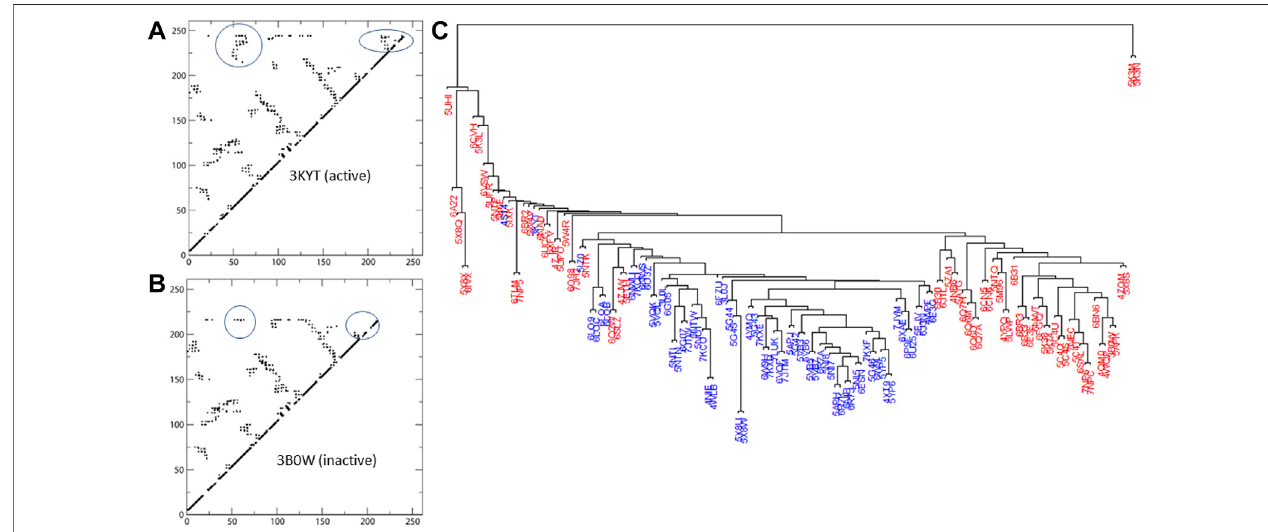
FIGURE 2 | Active and inactive structures of ROR γ are rendered as contact maps in (A,B) , respectively. Based on the similarity matrix, a dendrogram of the structures (active labeled in blue, inactive in red) at the contact level is displayed in (C) .